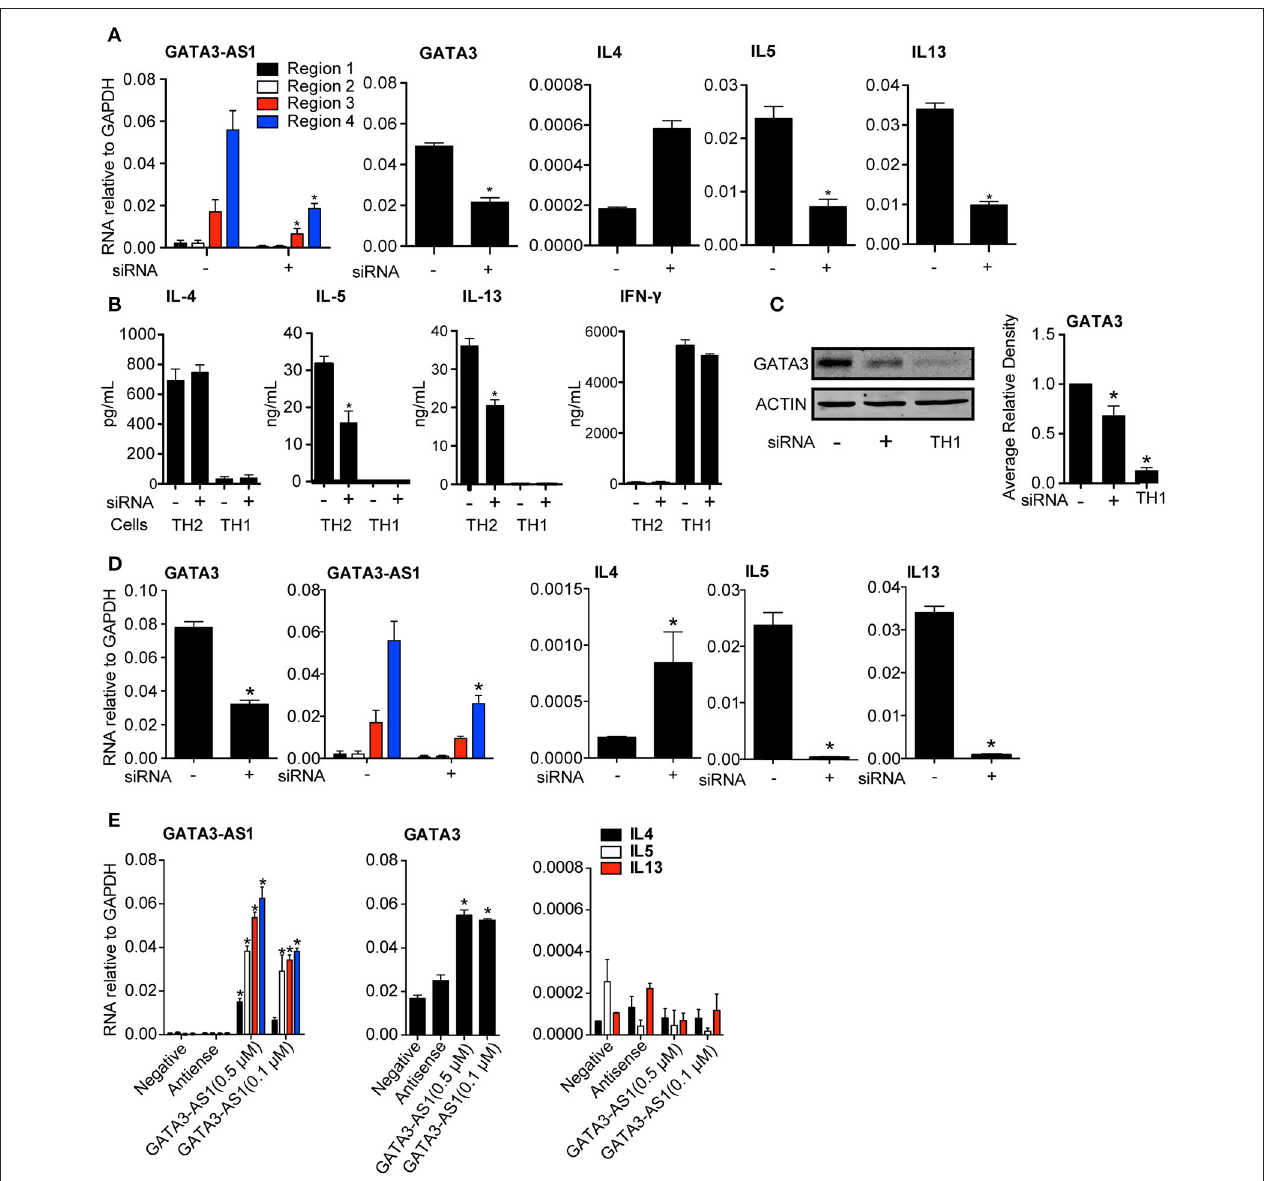
FIGURE 3 | GATA3-AS1 and GATA3 form a necessary feed forward loop for TH2 polarization. (A) PBMCs were cultured under TH2 polarizing conditions for 2 days and transfected with a GATA3-AS1 specific siRNA ( + ) or scrambled siRNA (–). GATA3-AS1 , GATA3 , IL4 , IL5 , and IL13 transcripts were determined by qPCR on day 5 and results expressed relative to GAPDH . Statistical significance was determined using Students T -test by comparing GATA3-AS1 siRNA knockdown to scrambled control knockdown ( n = 3). * P < 0.05 (B) PBMCs were cultured under TH2 or TH1 polarizing conditions and transfected with GATA3-AS1 specific siRNA ( + ) or scrambled siRNA (–). Protein was analyzed by ELISA (for IL-4, IL-5, and IL-13, n = 3,) or (C) Western Blot (GATA3, Densitometry). Statistics were calculated using a Paired T -test compared negative siRNA controls. * P < 0.05. (D) Similar to A, but an siRNA specific to GATA3 was transfected on day 2. Results and statistics similar to A, but ( n = 4). (E) PBMCs were cultured under TH0 conditions for 2 days, and transfected with GATA3-AS1 transcripts produced from Topo-TA in vitro transcription vector. Cells were transfected with a scrambled siRNA (negative), the antisense of GATA3-AS1 (antisense), GATA3-AS1 at 500 µ M (AS1 High), and GATA3-AS1 at 100 µ M (AS1 Low). Analysis and statistics completed similarly to A and B, ( n =